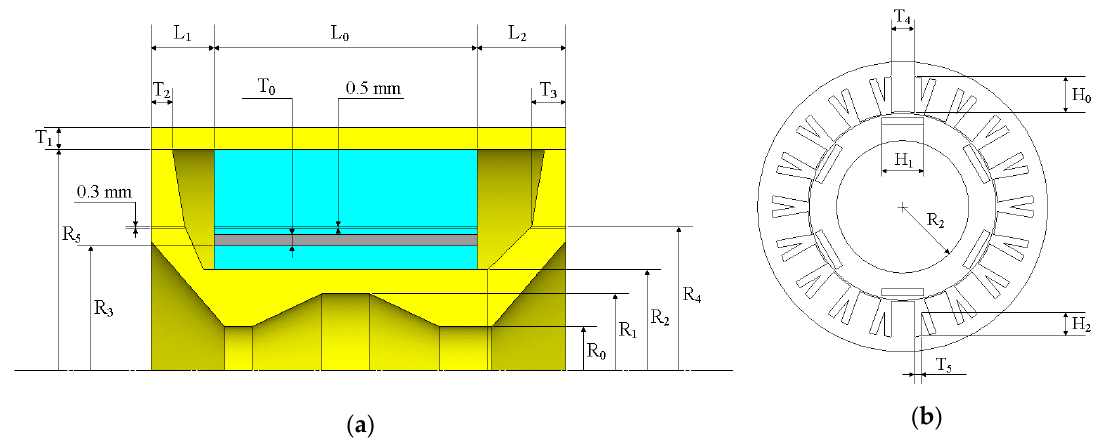
Figure 13. Main design dimensions. ( a ) Longitudinal cut view; ( b ) stator and rotor laminations.